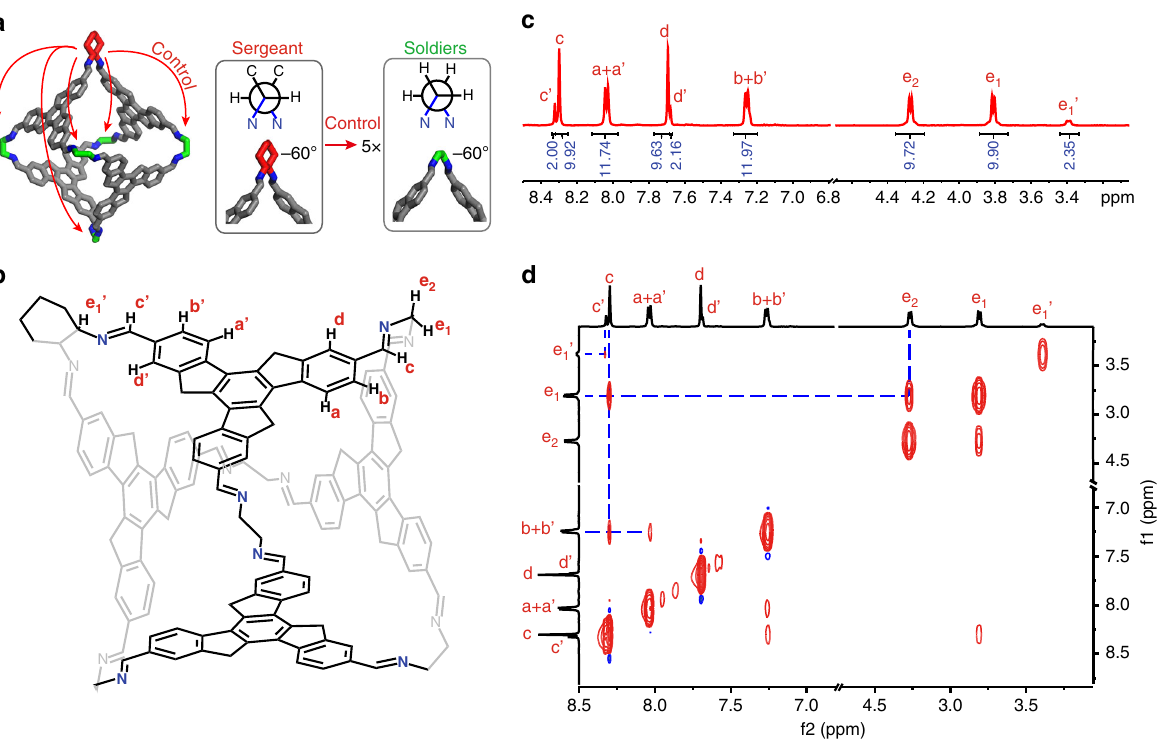
Fig. 4 NMR analysis of 1 5 2 1 to reveal the chirality transfer inside single octahedra. a Schematic of an 1 5 2 1 octahedron shows that one ( R , R )-CHDA sergeant is suf fi cient to fully control all EDA soldiers in the octahedron squad. b Structure of 1 5 2 1 , with propyl groups omitted for clarity and protons labelled. c 1 H NMR and d NOE spectrum of 1 5 2 1 , with peaks labelled corresponding to the proton labelling in ( b